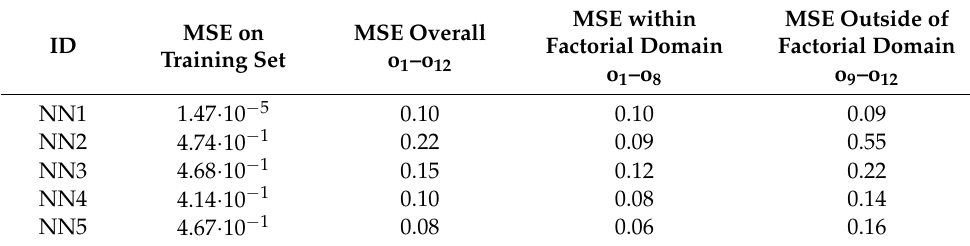
Table 6. Neural network ranking